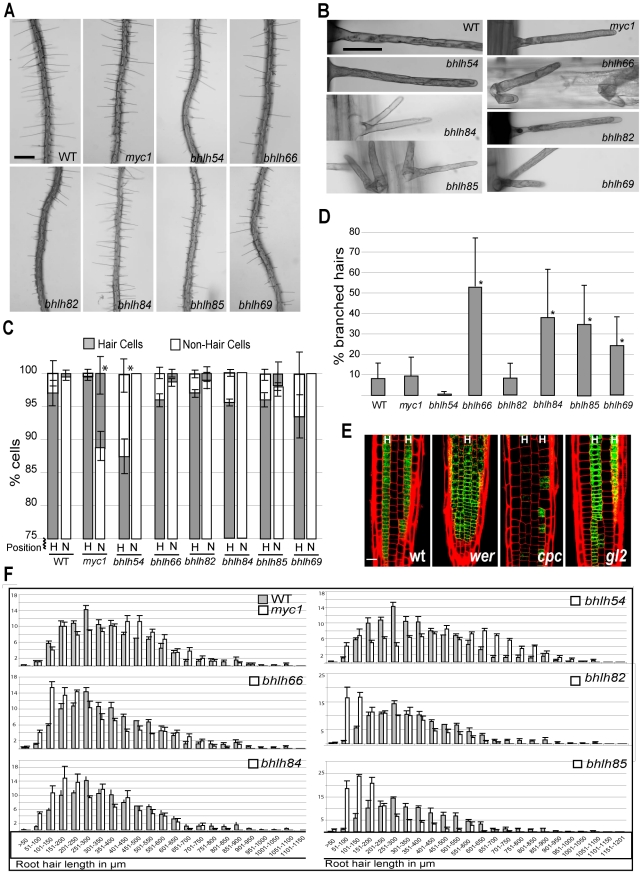
Analysis of bHLH transcription factor genes involved in root epidermis development.(A) Low magnification view of roots from wild-type and homozygous bHLH mutants. Scale bar: 200 µm. (B) High magnification view of individual root hairs from wild-type and each mutant. Scale bar: 30 µm. (C) Cell-type pattern analysis, showing the fraction of root-hair cells and non-hair cells that lie in the H and N cell positions, respectively, of the root epidermis. Mutants which differ significantly from the wild type (p<0.05) are indicated with an asterisk. Some columns lack error bars because all values were identical. (D) Analysis of root hair branching. Mutants which display a significantly greater proportion of branched root hairs than the wild type (p<0.005) are indicated with an asterisk. (E) Expression of the MYC1::GFP transcriptional reporter fusion in the root epidermis of wild-type and mutants. The location of H-cell files is designated by “H”. Scale bar: 20 µm. (F) Root hair length in wild-type and bHLH mutants. The length of full-grown root hairs was measured and the number of hairs in each 50 µm class was determined for each mutant line (white bars) and compared to the wild type (gray bars). Each of the six mutants shown here displayed a significantly different distribution of root hair lengths from wild type (p<0.005). The bHLH69 mutant did not exhibit a significant difference in root hair length distribution and is not shown. In panels (C), (D), and (F), error bars indicate standard deviation.